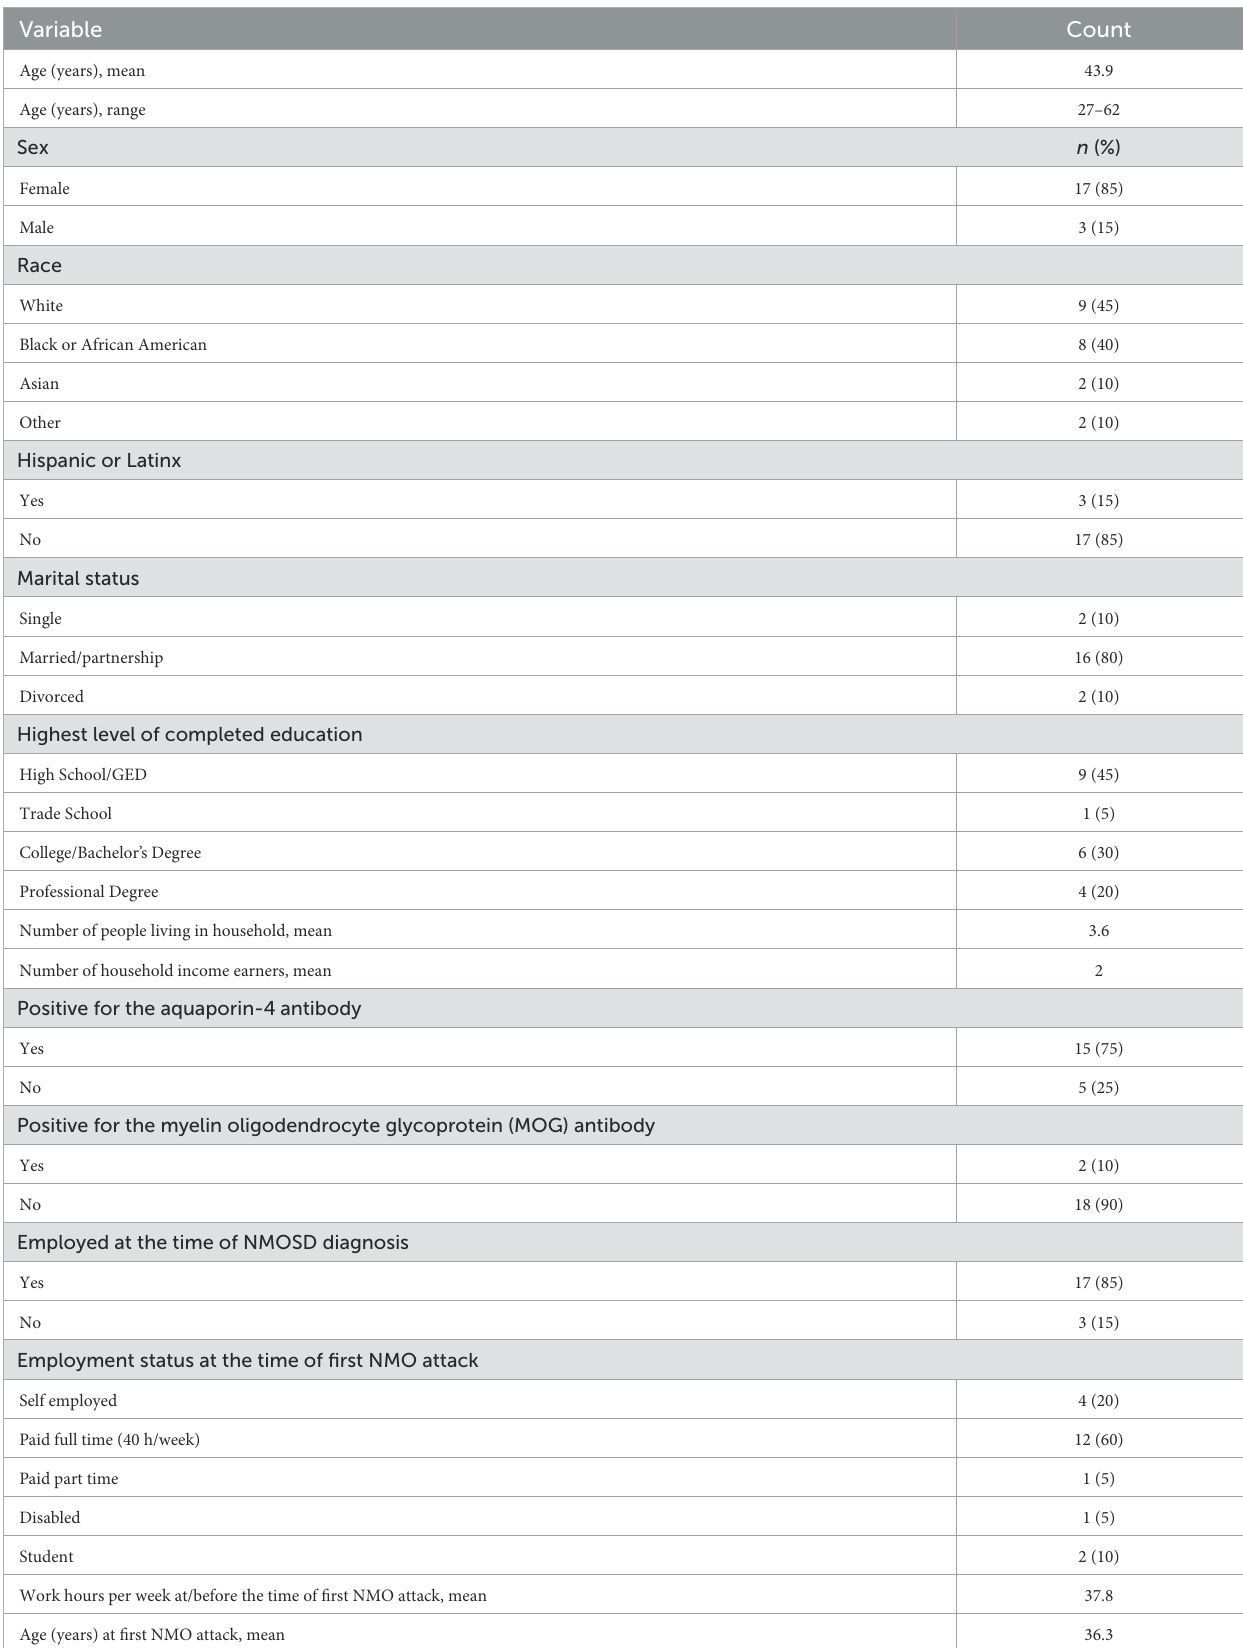
TABLE 1 Participant characteristics ( n =